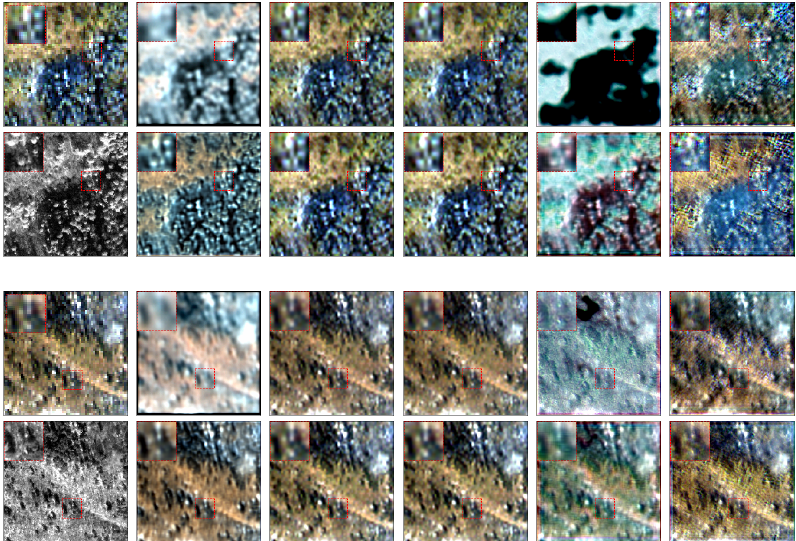
Figure 7. Fused results of two randomly selected samples from the IKONOS test set. From left to right are the original LRMS/PAN images, results of PNN, RSIFNN, PanNet, PSGAN, and the PercepPan with the ESRGAN generator,